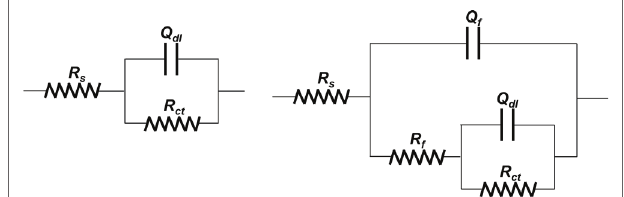
FIGURE 9 | Electrical equivalent circuit used for fitting EIS results.